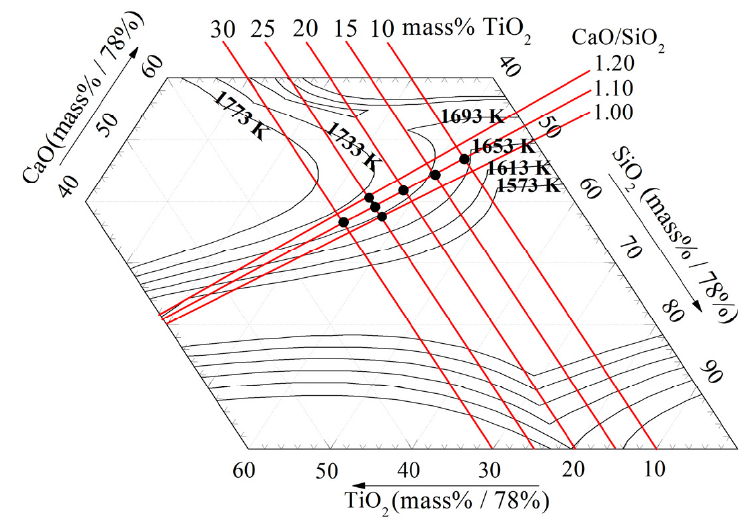
Figure 3. Phase diagram of CaO-SiO 2 -8 mass% MgO-14 mass % Al 2 O 3 -TiO 2 slag, K.